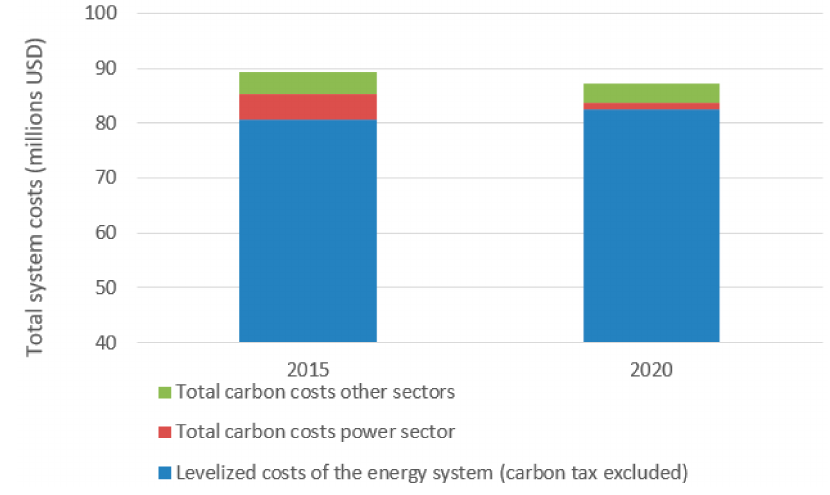
Figure 3. The total system costs of energy systems in 2015 and 2020 (note that y -axis does not start at zero).